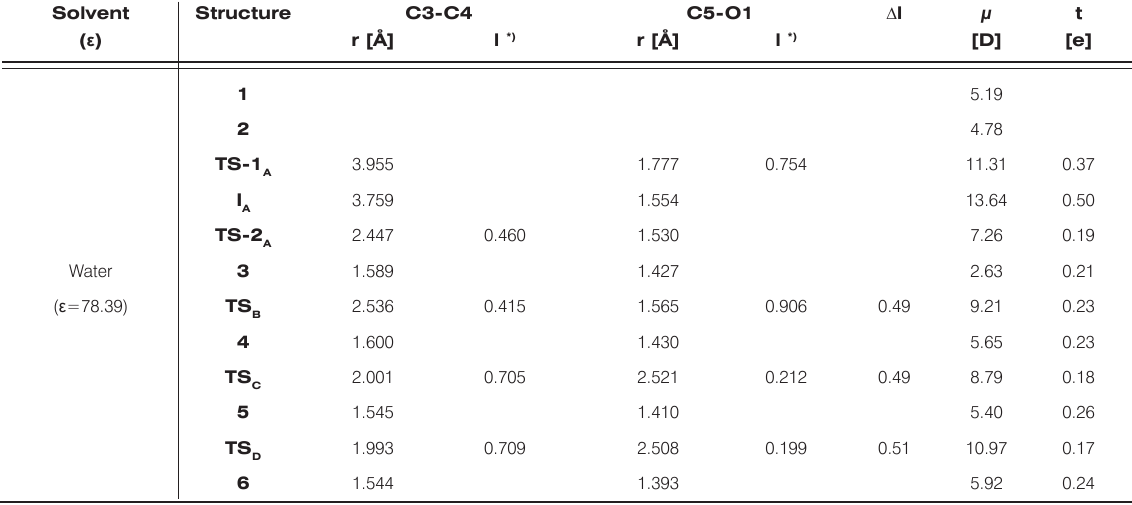
When nitromethane (ε=38.20) is used as a dielectric medium, the LM complex valleys in the A-D energy profiles disappear, and the addent conversion to cycloadducts 3-6 follows a different mechanisms. For example, for reaction A, two TS ’s separated by a shallow intermediate trough I are located in the energy profile (Figs. 3 and 4, Scheme 3). In the first phase, a TS-1 complex is produced A l=0.762). At the same time the distance between the C3 and C4 reaction centres (r=3.928 Å) is well beyond the range typical [22] of a C-C bond in transition complexes of one-step [2+3] cycloadditions.